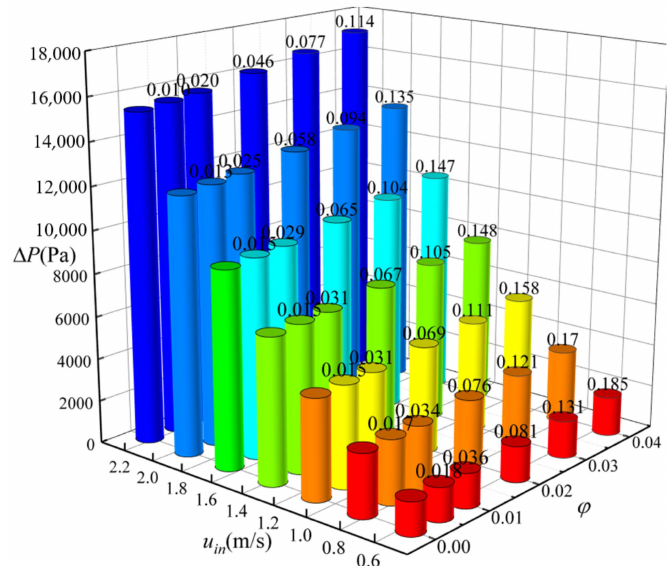
Figure 5. Relationship between ∆ P and fluid velocity as well as ϕ